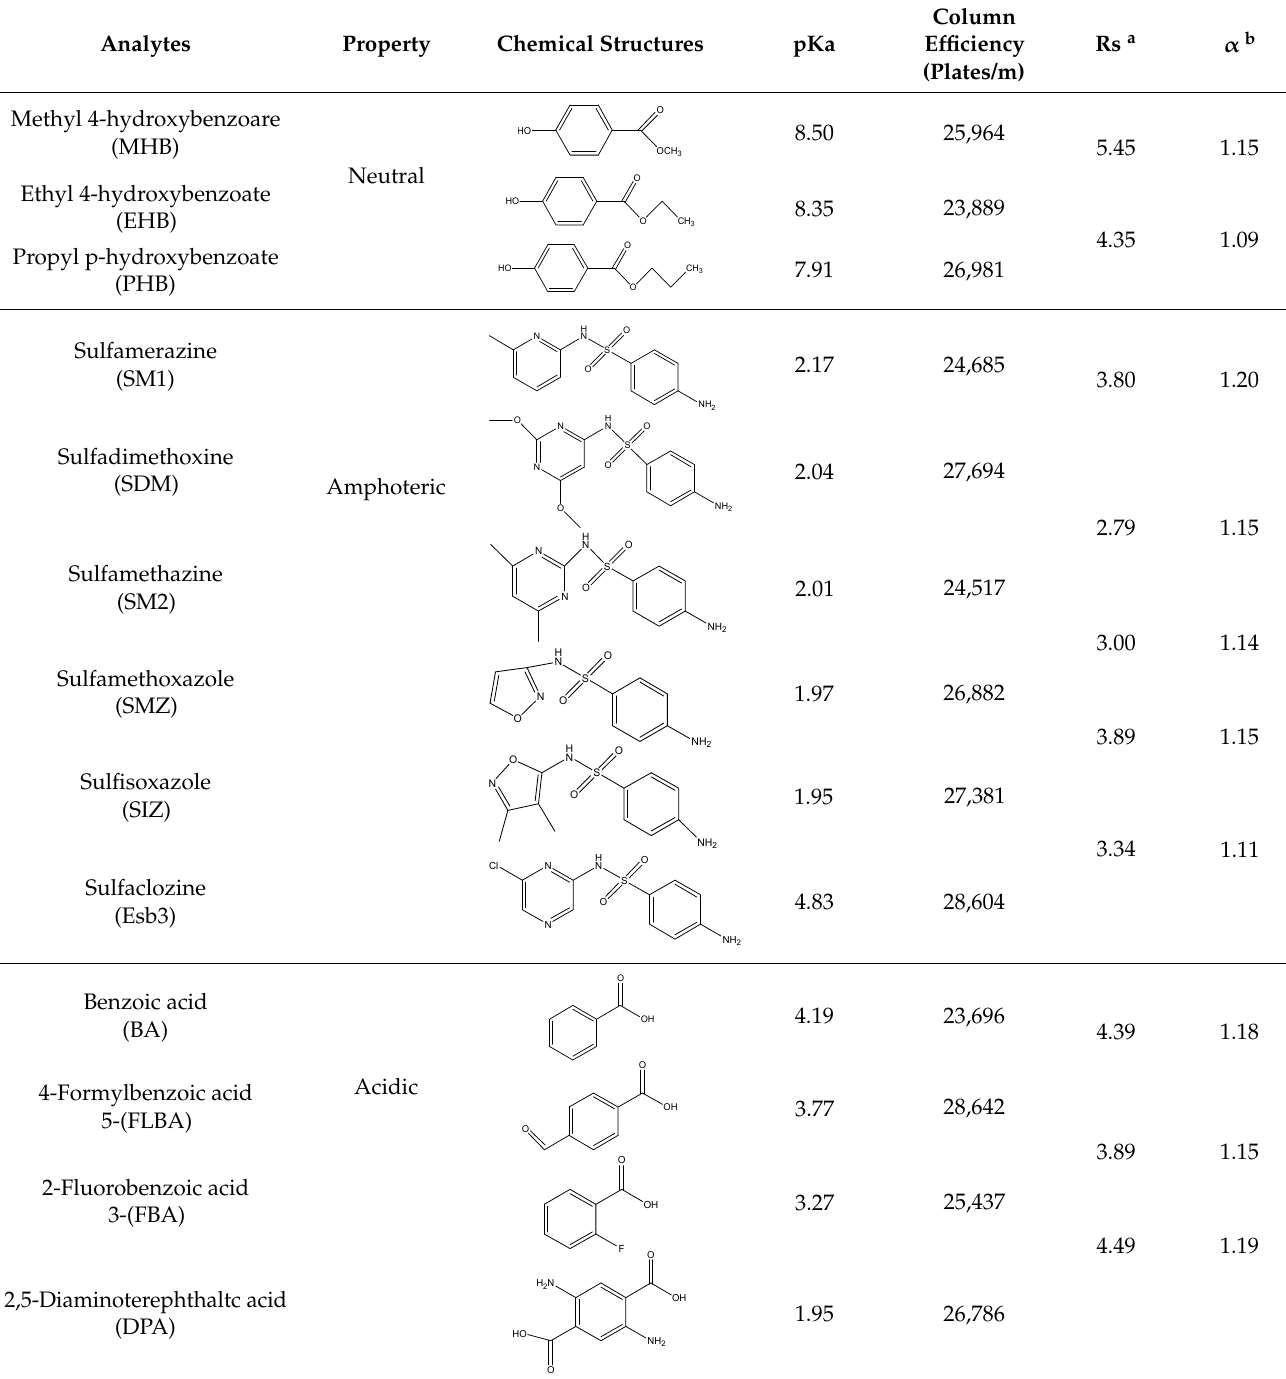
Table 3. Structures, pka values, Rs and α of the small molecular compounds studied.